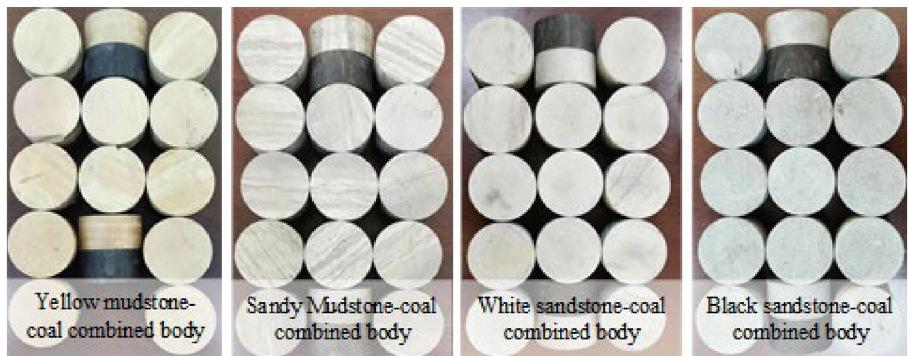
Figure 2. CRCB specimens prepared with four different rock sample and identical coal samples.